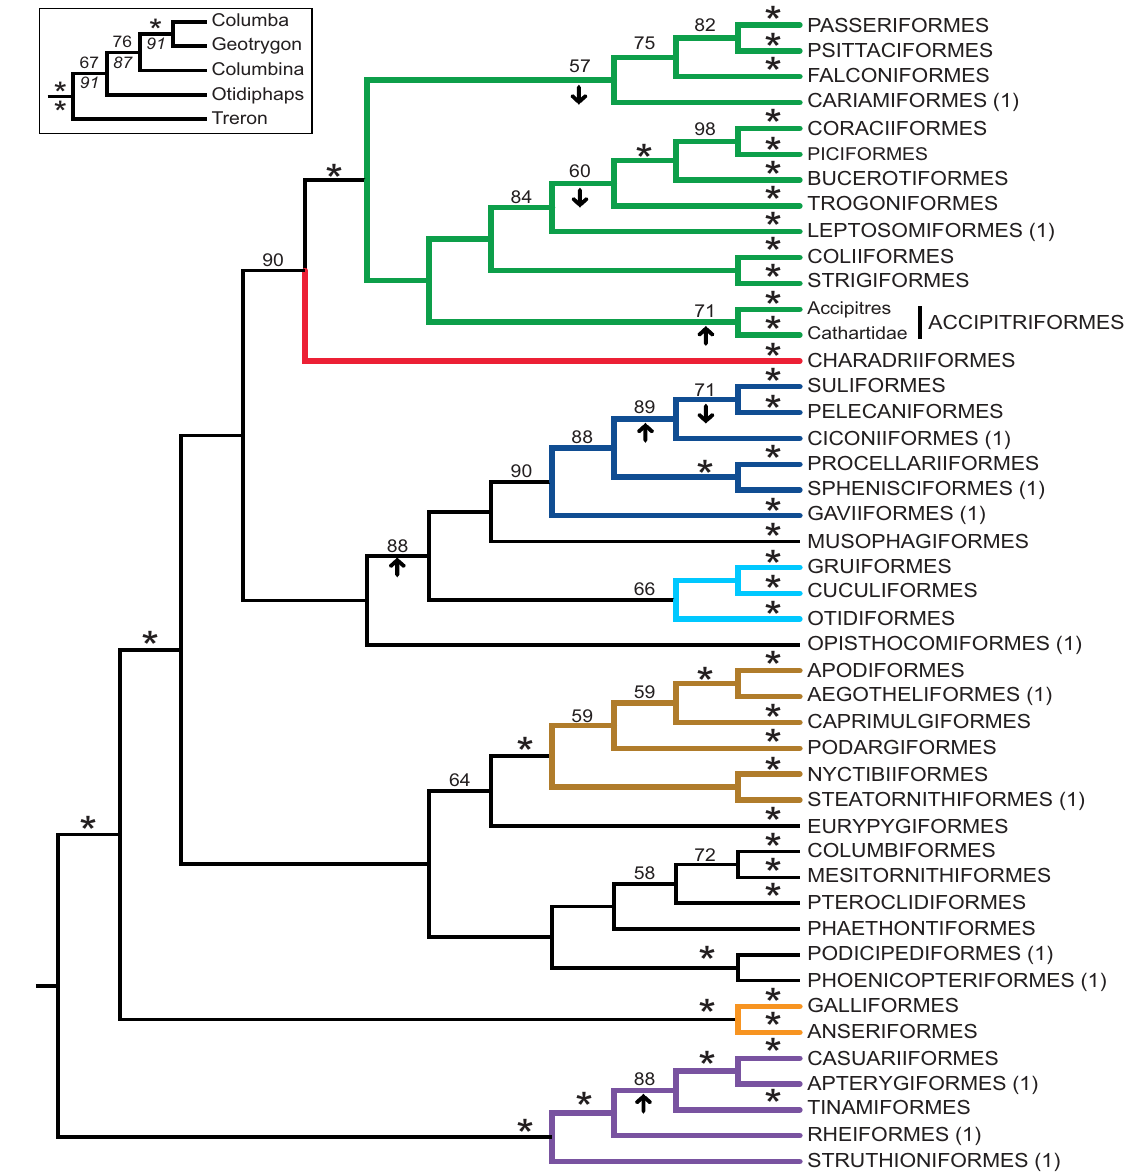
Figure 6. Combined evidence estimate of the avian tree of life. A partitioned ML analysis was conducted using the (cid:42)(cid:55)(cid:53)(cid:14)(cid:44)(cid:14)(cid:299)(cid:3) (cid:80)(cid:82)(cid:71)(cid:72)(cid:79)(cid:3) (cid:73)(cid:82)(cid:85)(cid:3) (cid:87)(cid:75)(cid:72)(cid:3) (cid:81)(cid:88)(cid:70)(cid:79)(cid:72)(cid:82)(cid:87)(cid:76)(cid:71)(cid:72)(cid:3) (cid:83)(cid:68)(cid:85)(cid:87)(cid:76)(cid:87)(cid:76)(cid:82)(cid:81)(cid:3) (cid:68)(cid:81)(cid:71) the (cid:38)(cid:41)(cid:49)(cid:89)(cid:14)(cid:299)(cid:3) model for the gap partition. Arrows indicate nodes defining supra-ordinal clades where bootstrap support increased or decreased by more than 10% relative to the nucleotide analysis (Figure 1). The combined evidence topology for Columbiformes was congruent with the gap topology instead of the nucleotide topology (inset; bootstrap values are reported for combined analysis [above branches] and for gap characters [below